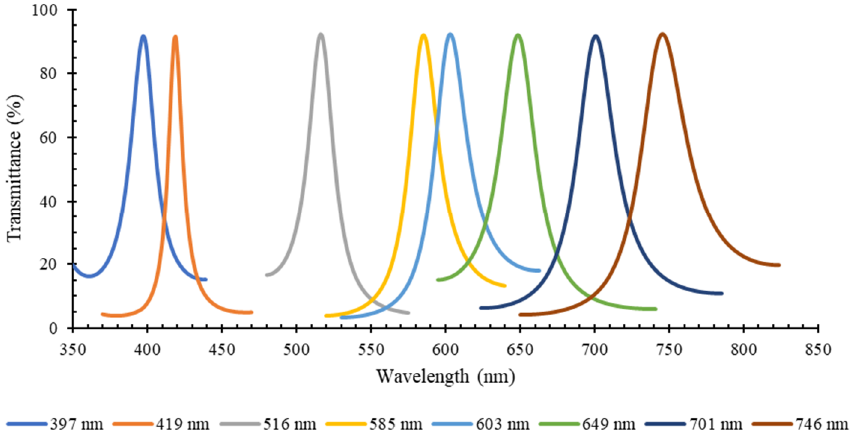
Figure 5. Simulation results of the central spectrum transmittance (%) vs. wavelength (nm), for the 8 designed MgO/TiO 2 and SiO 2 /TiO 2 optical filters, according to the structure and dimensions pre- sented in Table 1.